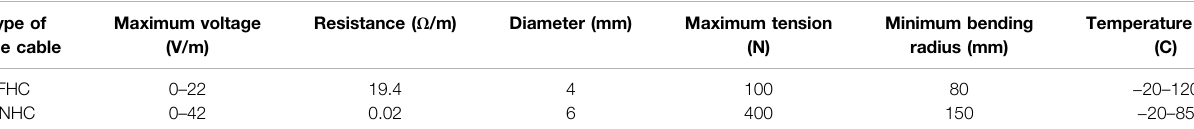
Frontiers in Sensors |